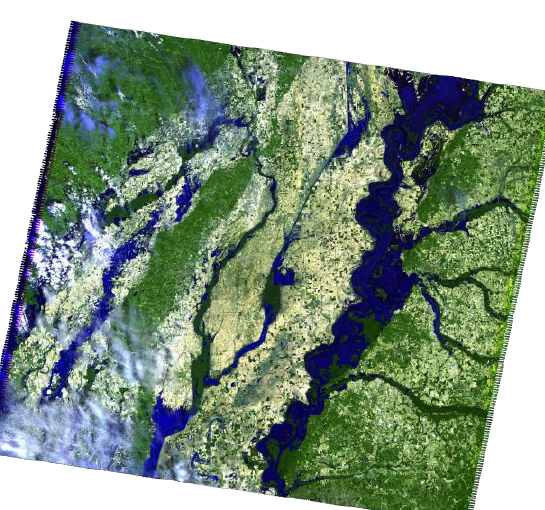
Figure 1. Landsat 5 Thematic Mapper acquired on 10 May 2011 shows the flooding in the Mississippi River, USA (Image credit: